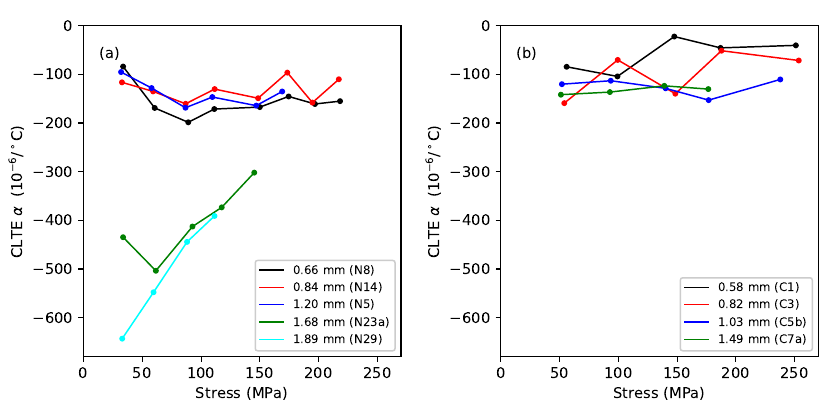
Figure 11. The coe ffi cient of linear thermal expansion (CLTE) along the strings, plotted against the applied stress, for ( a ) nylon, and ( b ) fluorocarbon. The CLTE values were derived from the thermal tension sensitivity, in the absence of any tuning adjustments, and the thermal variation in the Young’s